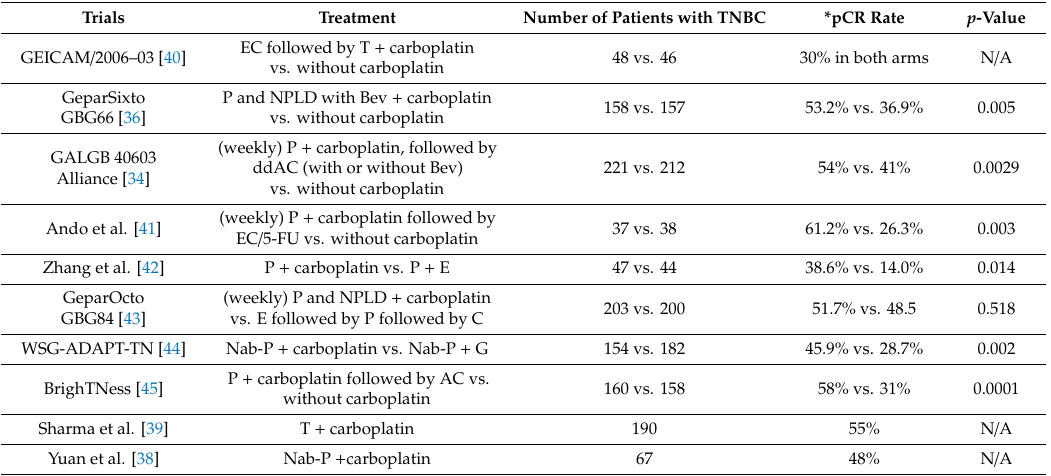
Table 2. Pathological complete response (pCR) rate in neoadjuvant trials with carboplatin in early stage